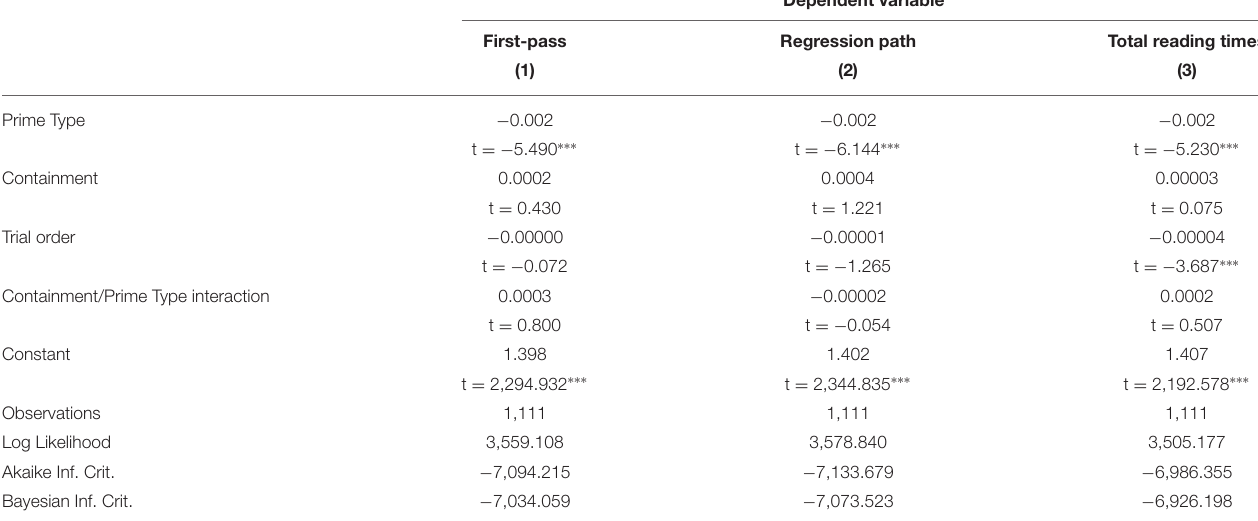
TABLE 4 | Regression analysis of reading times in the NOUN region of Experiment